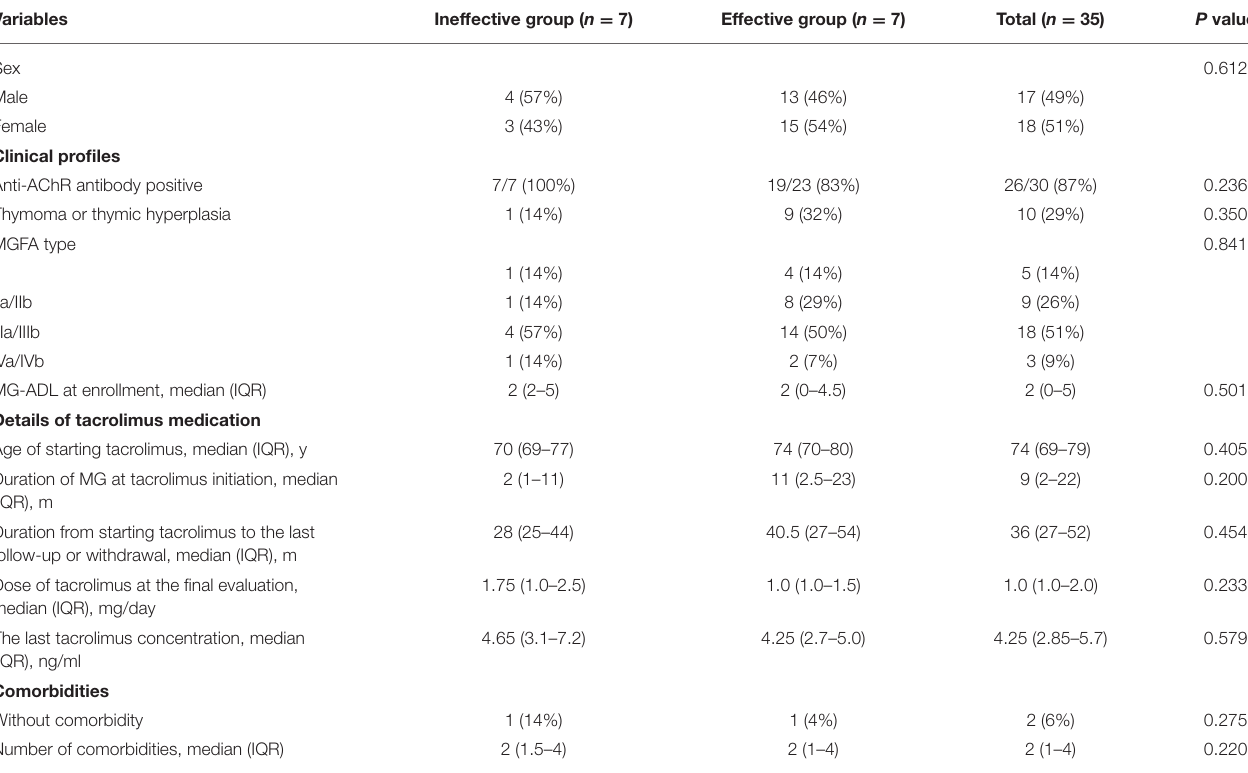
TABLE 4 | Characteristics of VLOMG patients in the Tac group according to clinical